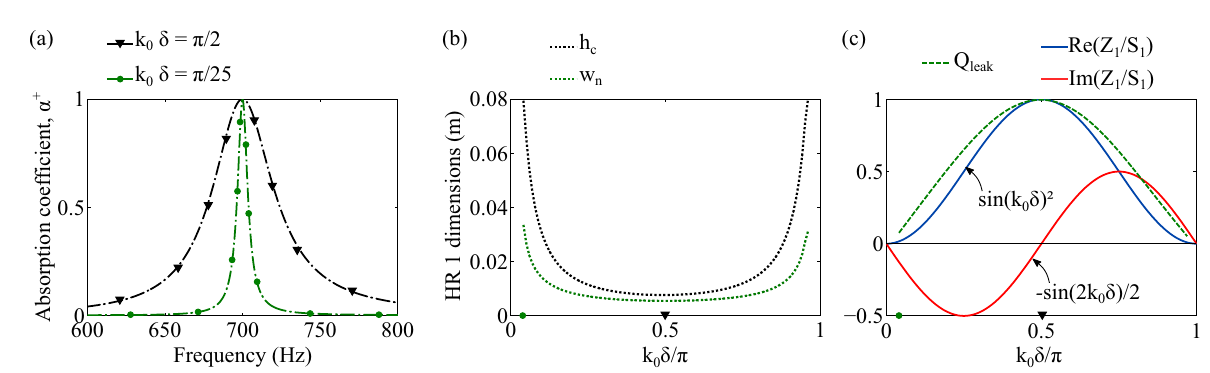
π 1 with k 0 ( 700 Hz )δ 0 and with = ∈ ] ; [ π/ 2 and for k 0 ( 700Hz )δ =